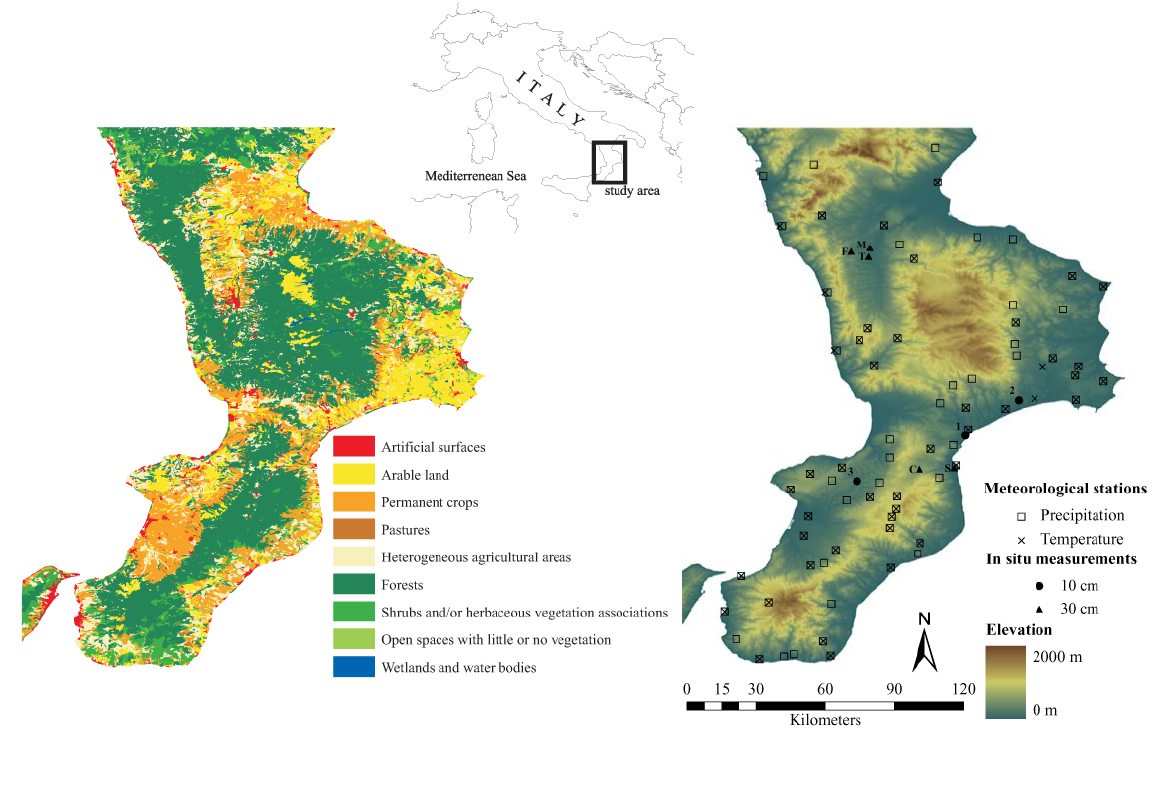
Fig. 1. Left panel: Corine land cover 2000 map of the study site. Right panel: topography of the study site and location of meteorological stations and in situ measurement locations (F=Fitterizzi, M=Mongrassano, T=Torano, C=Chiaravalle,